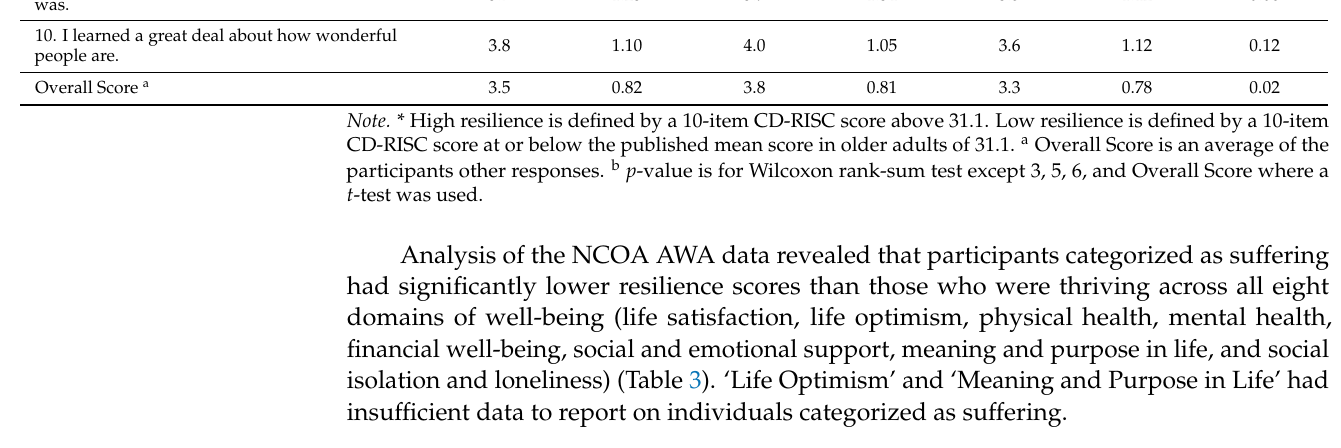
Table 3. Resilience scores by well-being domain and response